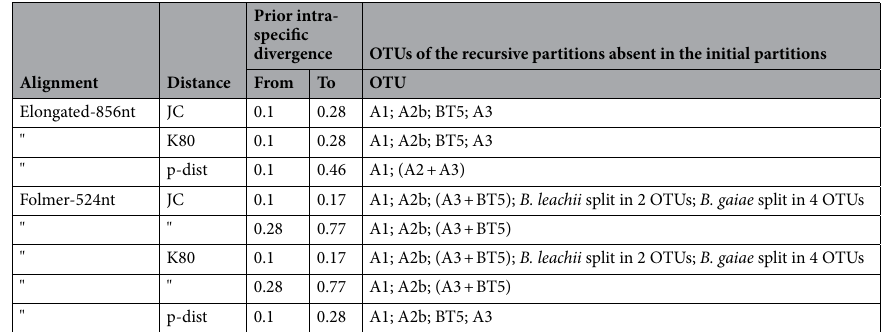
Table 5. OTUs identified only in some recursive partitions of the ABGD analyses. OTU names are defined as in Table 4.